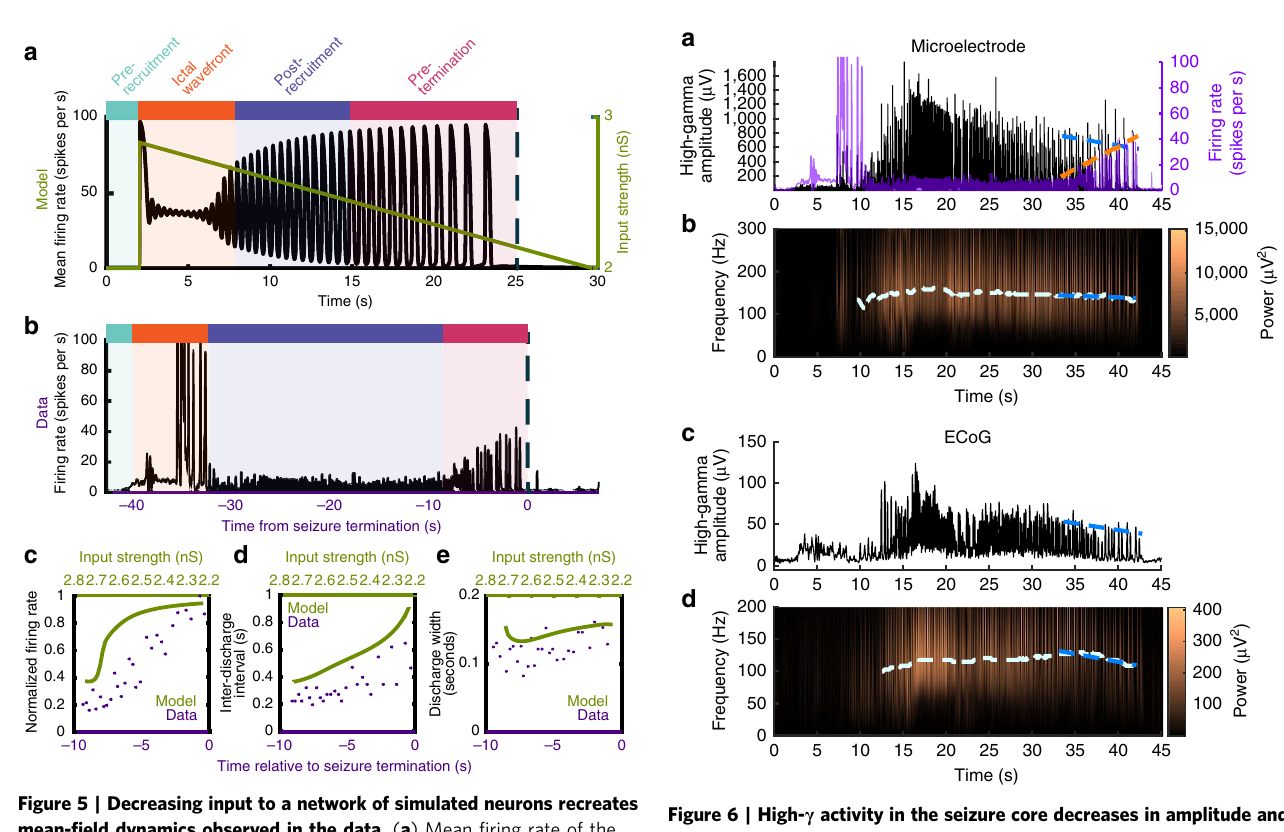
Figure 6 | High- c activity in the seizure core decreases in amplitude and frequency before seizure termination. ( a ) High- g instantaneous amplitude and multiunit firing recorded from an example microelectrode through the duration of the same seizure shown in Fig. 5b. The blue dotted line indicates linear regression of the peak high- g amplitude for each discharge during the pre-termination epoch, and the orange dotted line similarly indicates peak firing rate. ( b ) Spectrogram of the same seizure in a . The white dotted line indicates peak high- g frequency through the duration of the seizure, and the blue dotted line indicates linear regression of the peak high- g frequency during the pre-termination epoch. c and d show the same seizure as in a and b recorded on the ECoG electrode adjacent to the microelectrode array. Dotted lines indicate the same linear regression measurements as in a and b